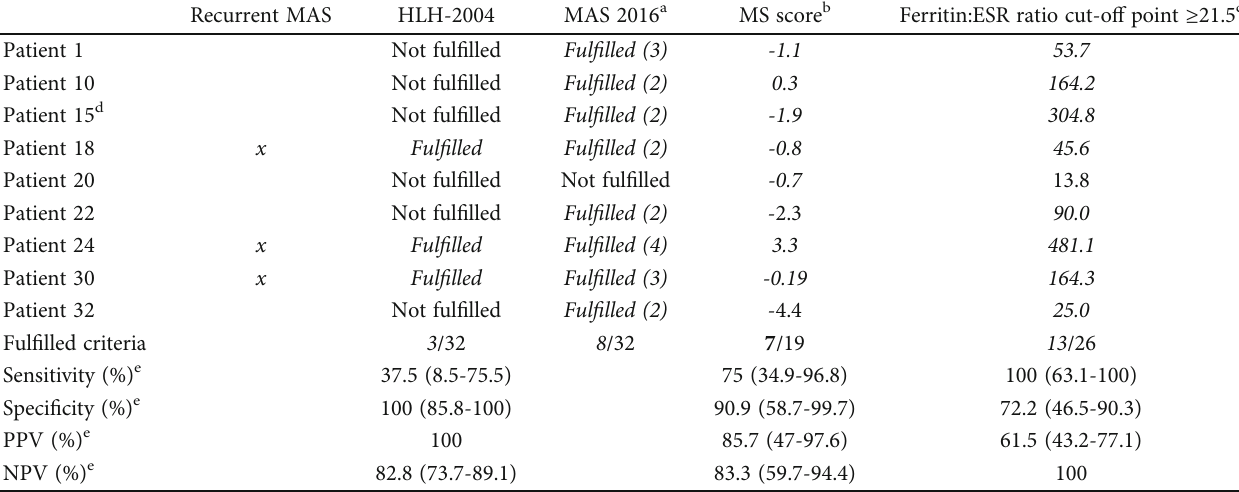
Table 2: SJIA patients classi fi ed with MAS according to the HLH-2004 diagnostic guidelines, MAS 2016 classi fi cation criteria, MS score, and/or ferritin/ESR ratio.